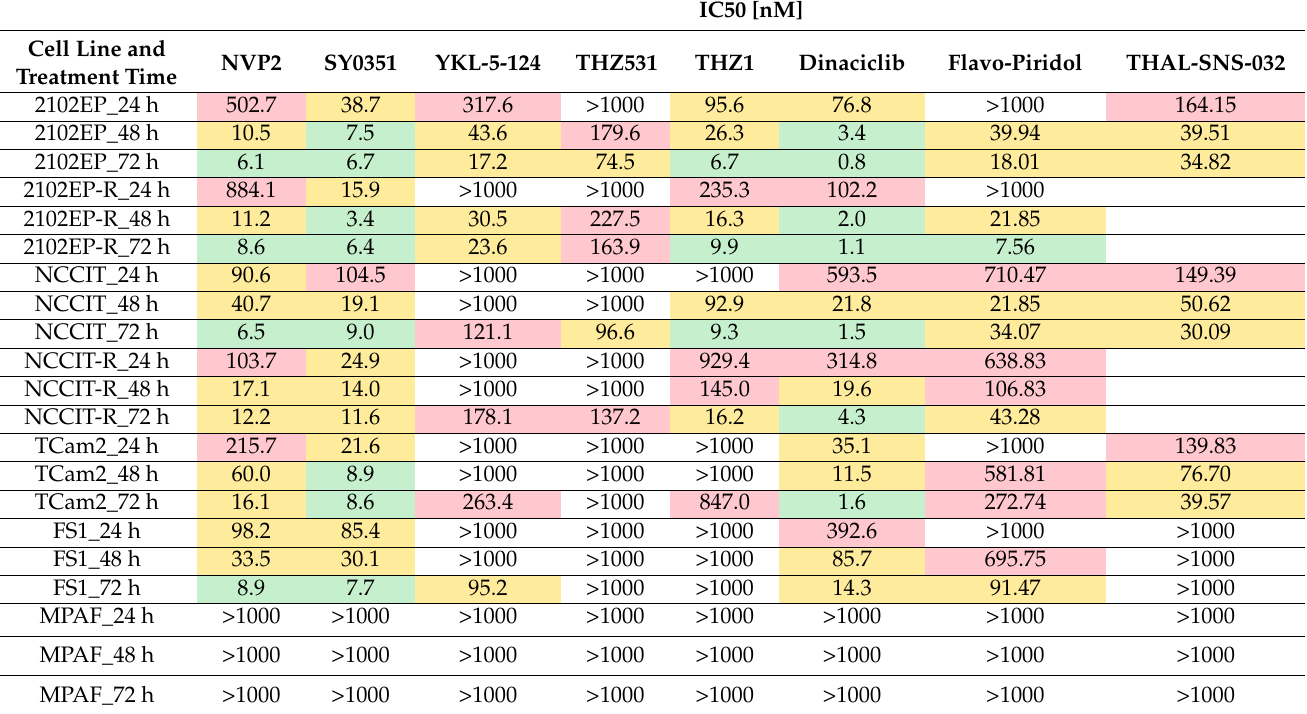
Table 2. IC50 values of TGCT and control cell lines. The calculation was performed based on the XTT viability. The values were subgrouped according to very high potency (green), high potency (yellow), moderate potency (red) and low potency (white). IC50